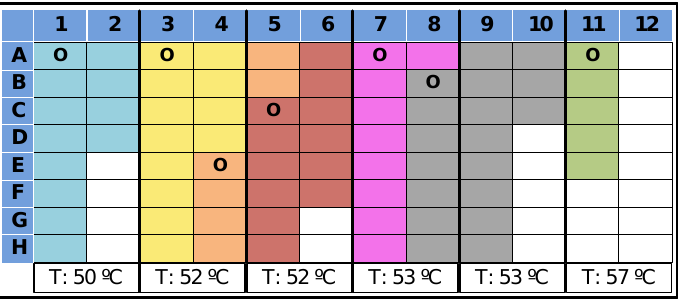
Figure 1. Example of a plate as used in the